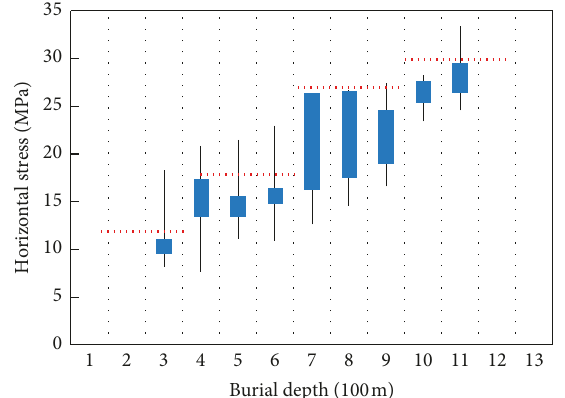
Figure 7: Relational graph of horizontal geostress and burial depth.